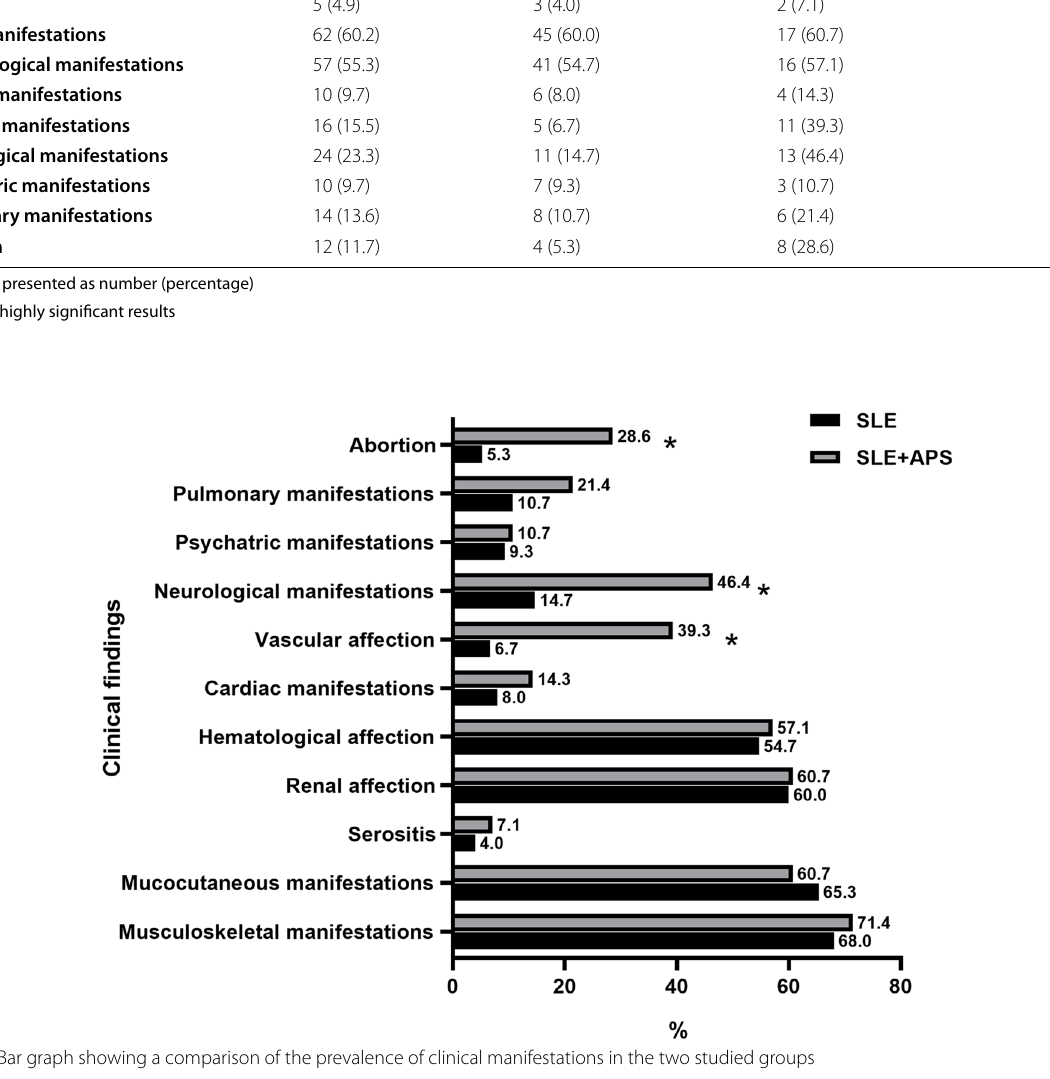
Fig. 1 Bar graph showing a comparison of the prevalence of clinical manifestations in the two studied